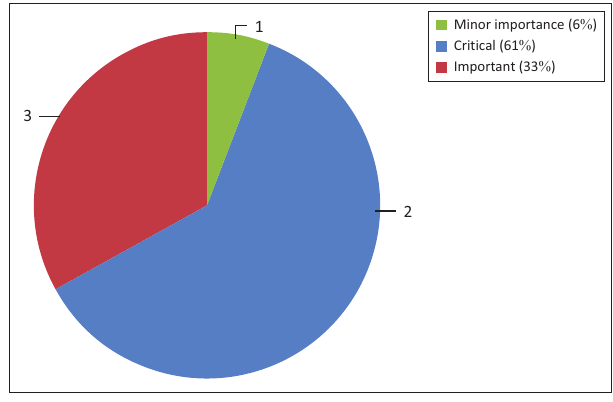
FIGURE 2: Ratio of importance ascribed to all activities within each strategic supply chain management process